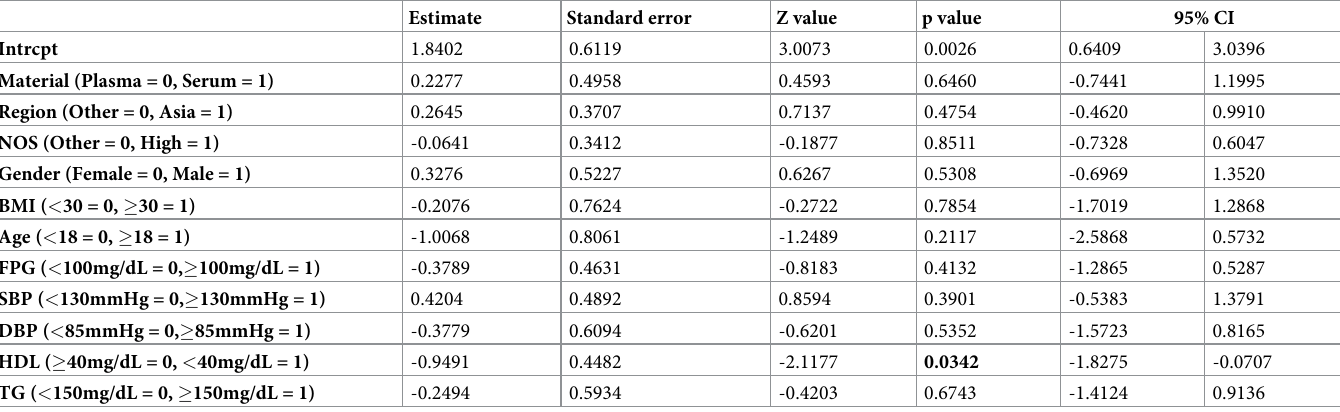
Table 2. Meta-regression of the studies for the fetuin-A and